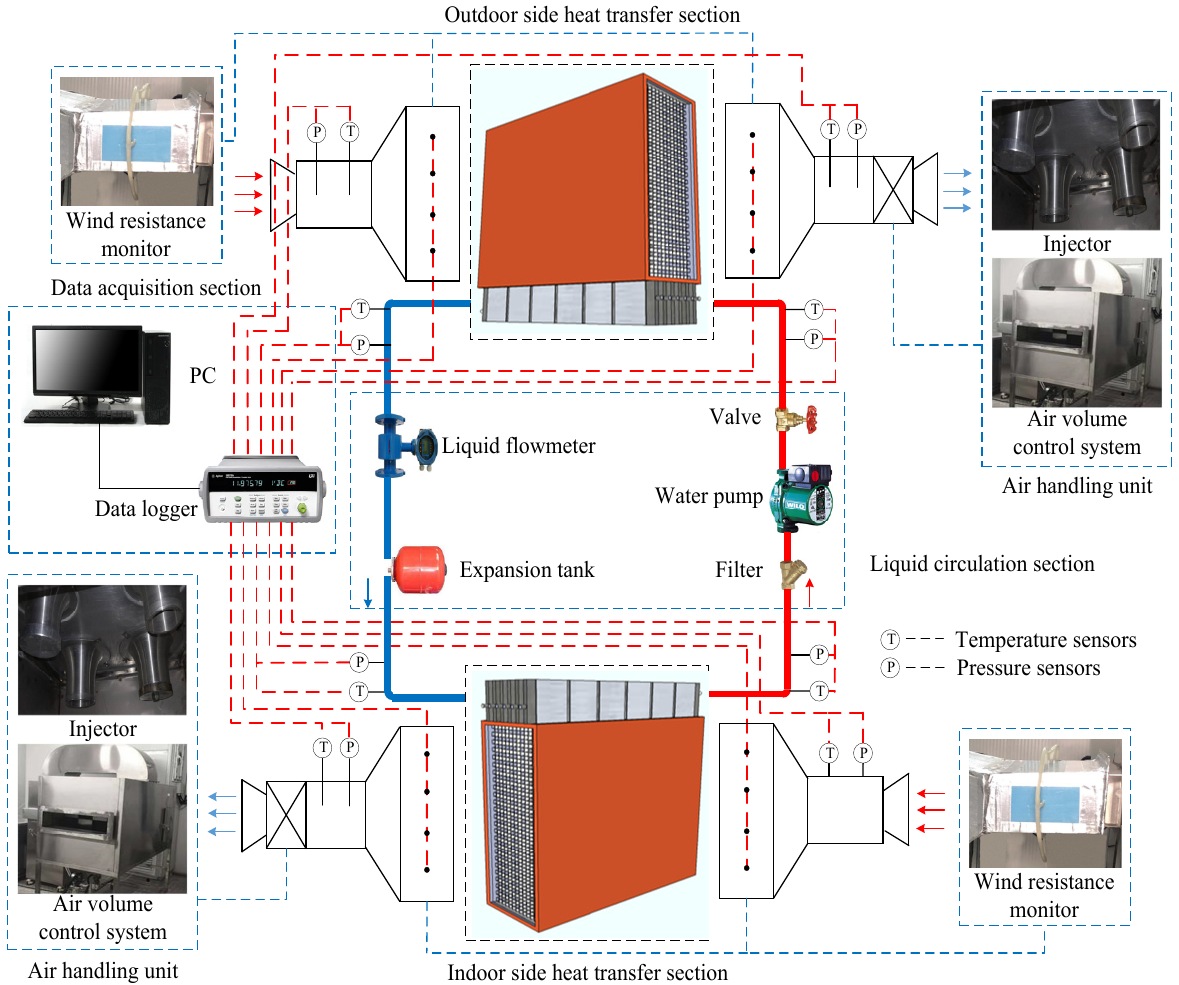
Figure 6. Experimental split natural cooling system.